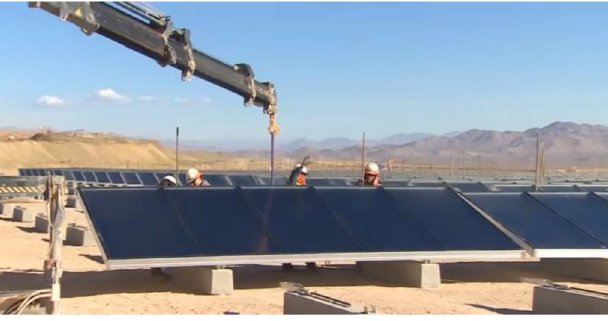
Fig. 14. Chile cooper mining heat process.